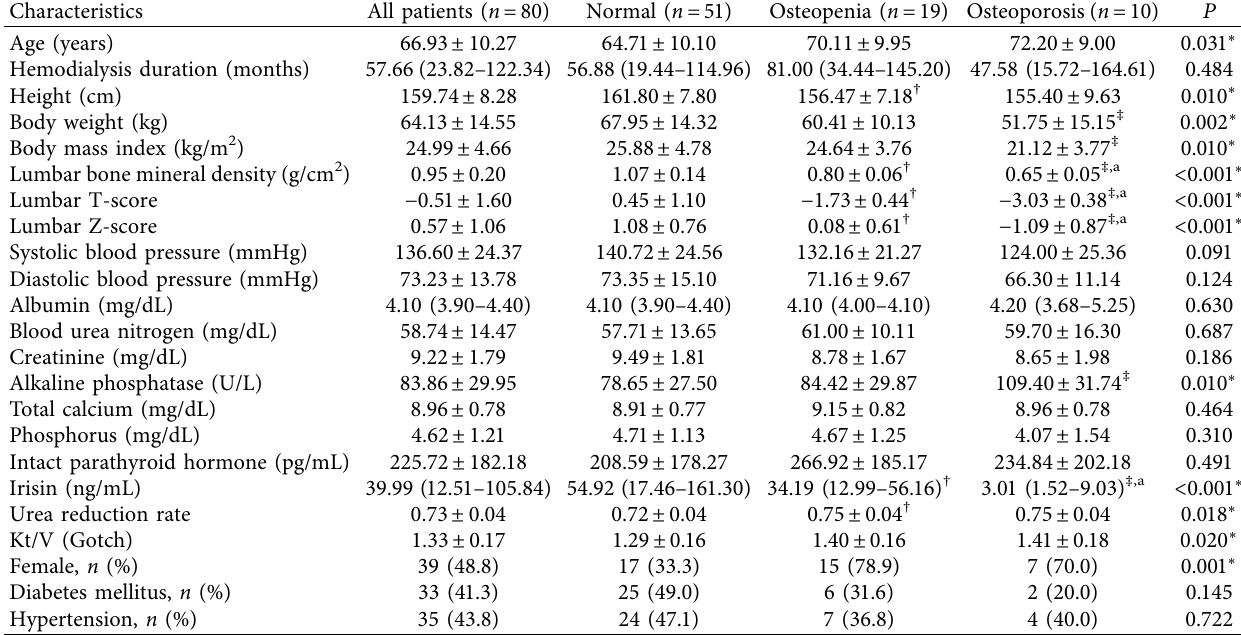
Table 1: Clinical characteristics according to different lumbar T-score cutoff points (normal, osteopenia, and osteoporosis) of the 80 hemodialysis patients.